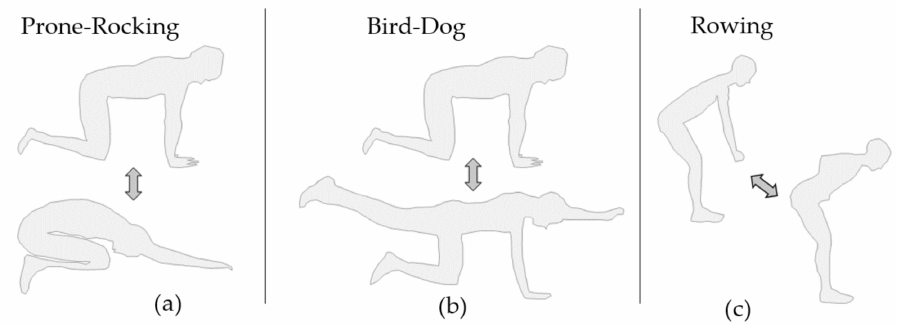
Figure 2. CPE: Exercises performed in clinically prescribed optimised form. ( a ) Prone-Rocking, ( b ) Bird-Dog and ( c ) Bent-over